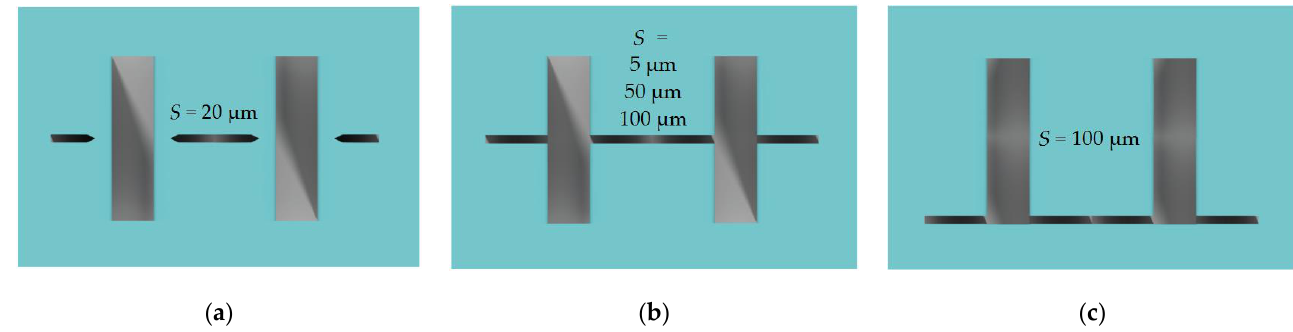
7 of 16 Table 2. Description of the test structure dimensions. Type of Cleaving Lines